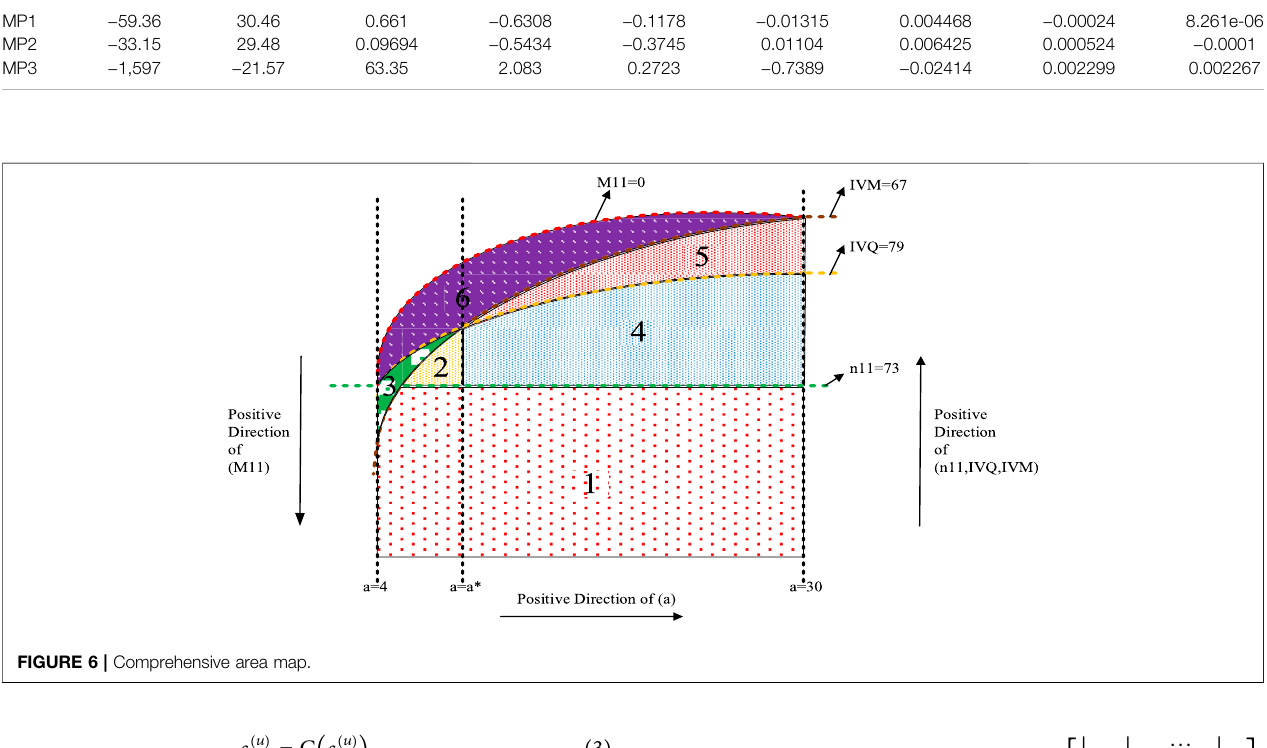
FIGURE 6 | Comprehensive area